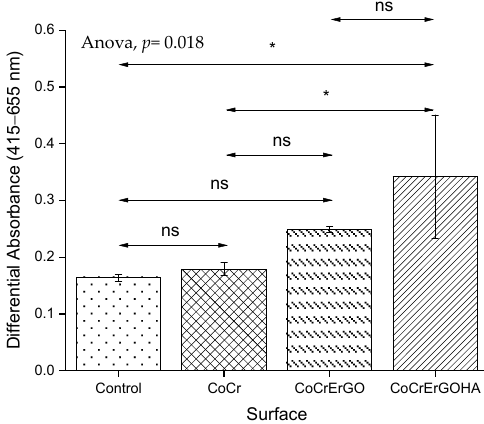
Figure 7. Effect of CoCr, CoCrErGO, and CoCrErGOHA on the proliferation and viability of osteoblast ‐ like MC3T3 ‐ E1 cell cultures. Osteoblasts were also cultured in the absence of any discs, and used as control. ns: p > 0.05, *: p ≤ 0.05.